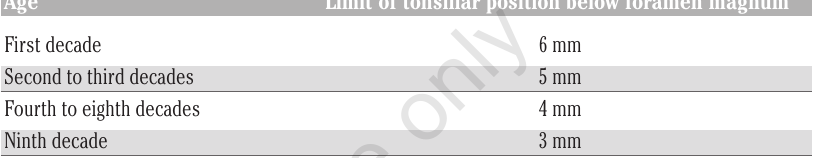
Table 2. Age-related position of the cerebellar tonsils.